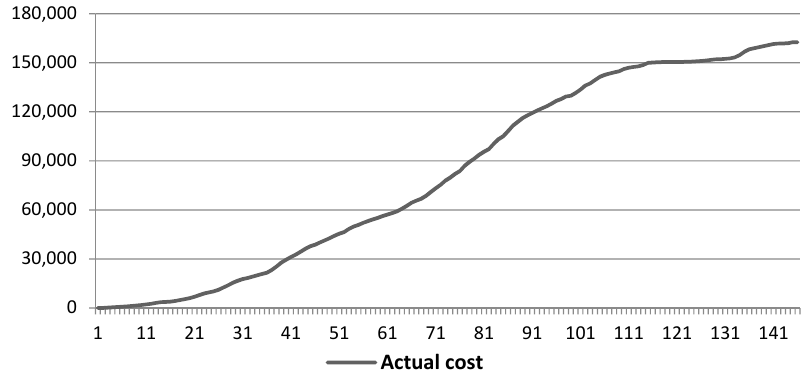
Figure 6. Actual cost S-curve.